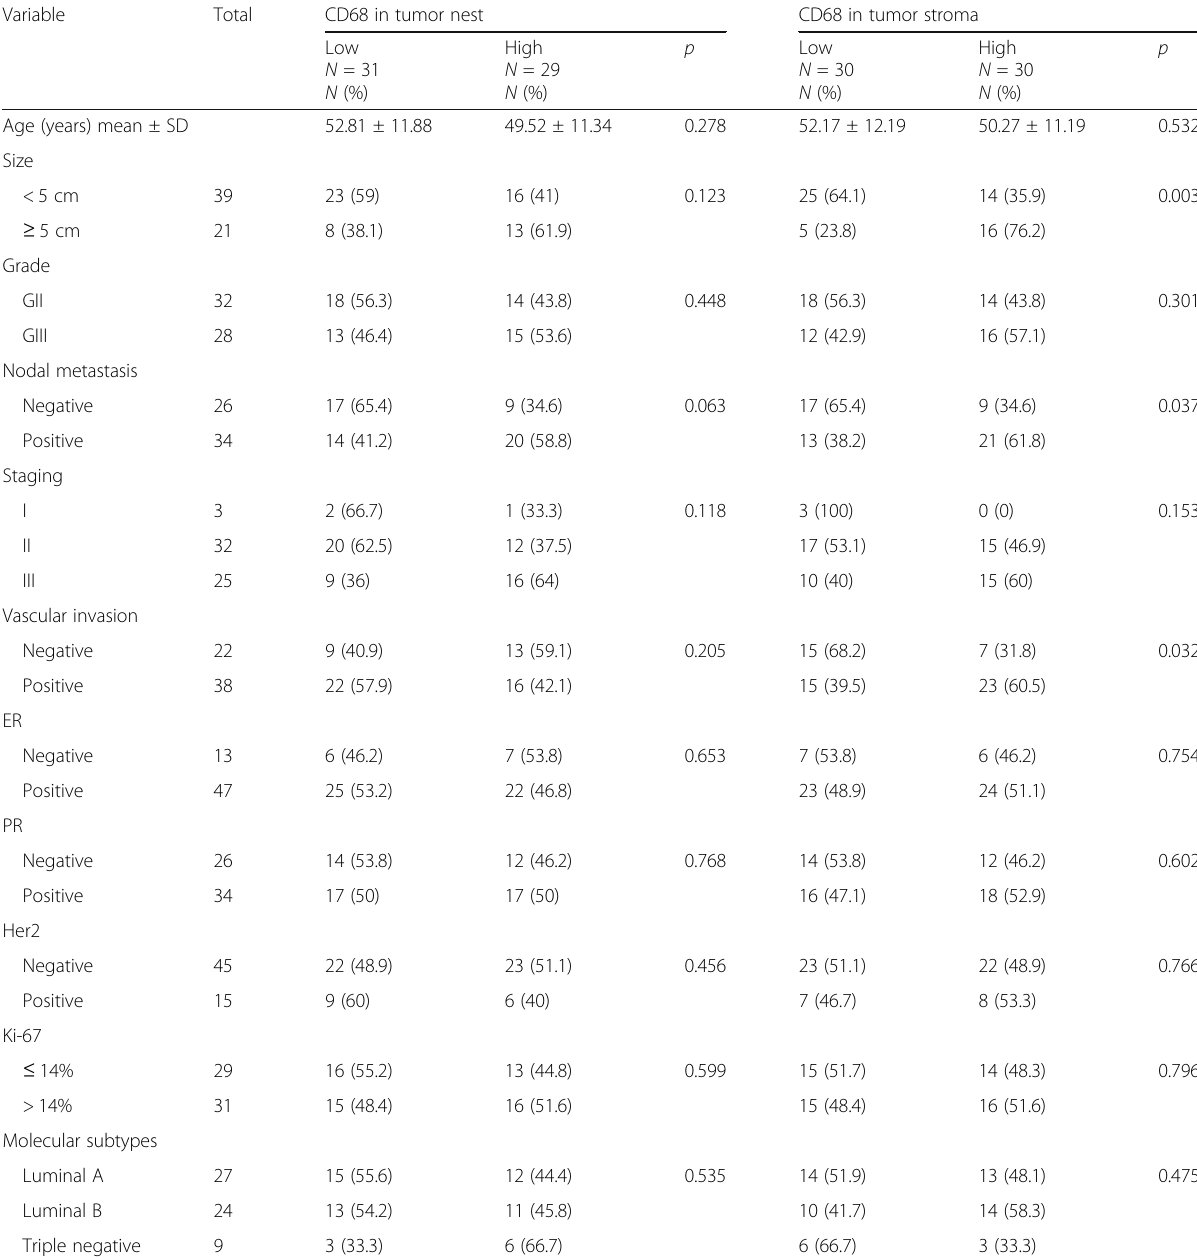
Table 2 Relation between CD68 expression in both tumor nest and stroma and clinicopathologic characteristics Variable